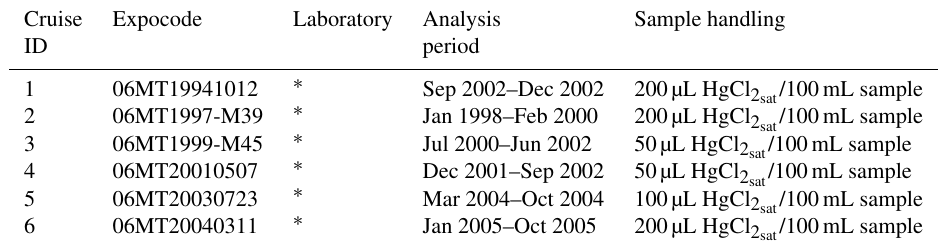
Table 2. Information about sample handling and measurements for those cruises of which the δ 13 C data have not been published elsewhere.